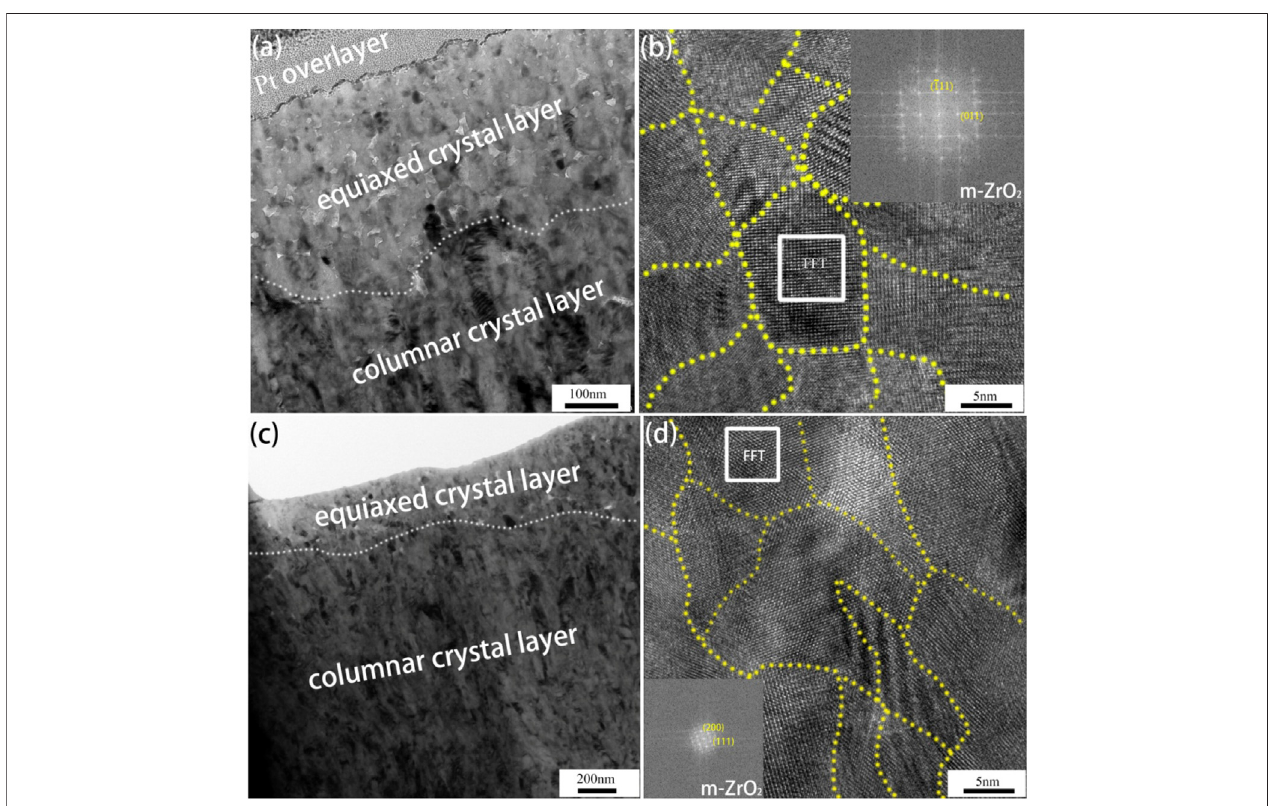
FIGURE 6 | TEM images and HRTEM images of oxide fi lms on the specimen tested in (A,B) B – Li and (C,D) NH 4 OH solutions after 300 days.